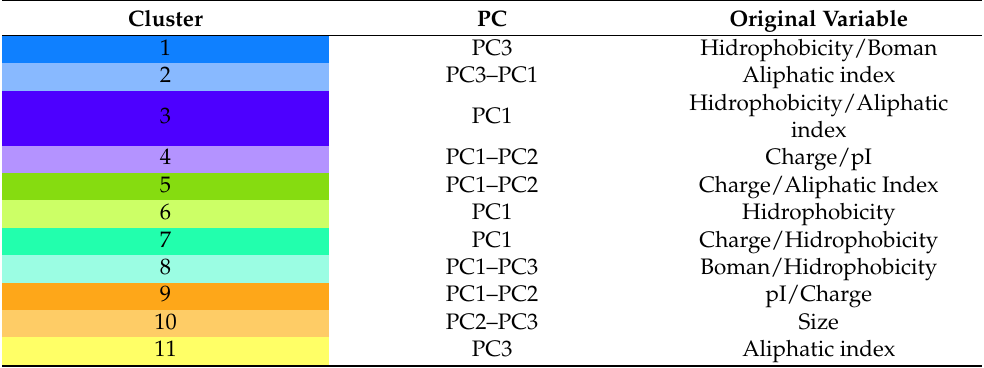
Table 3. PC and original variables associated with each cluster. Clusters are colored with the same color code as in Figure